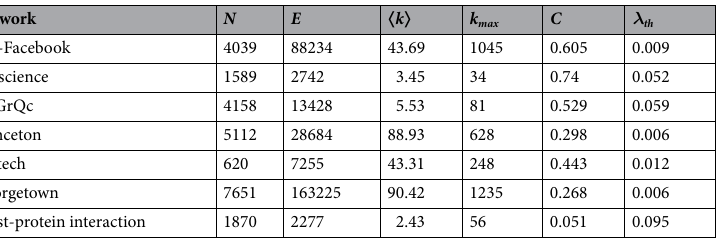
Table 5. Basic topological properties of the real-world networks. N is the number of nodes, E is the number of edges. 〈 k 〉 is the average degree, k max is the max degree. C is the average clustering coefficient. λ th is the epidemic threshold.